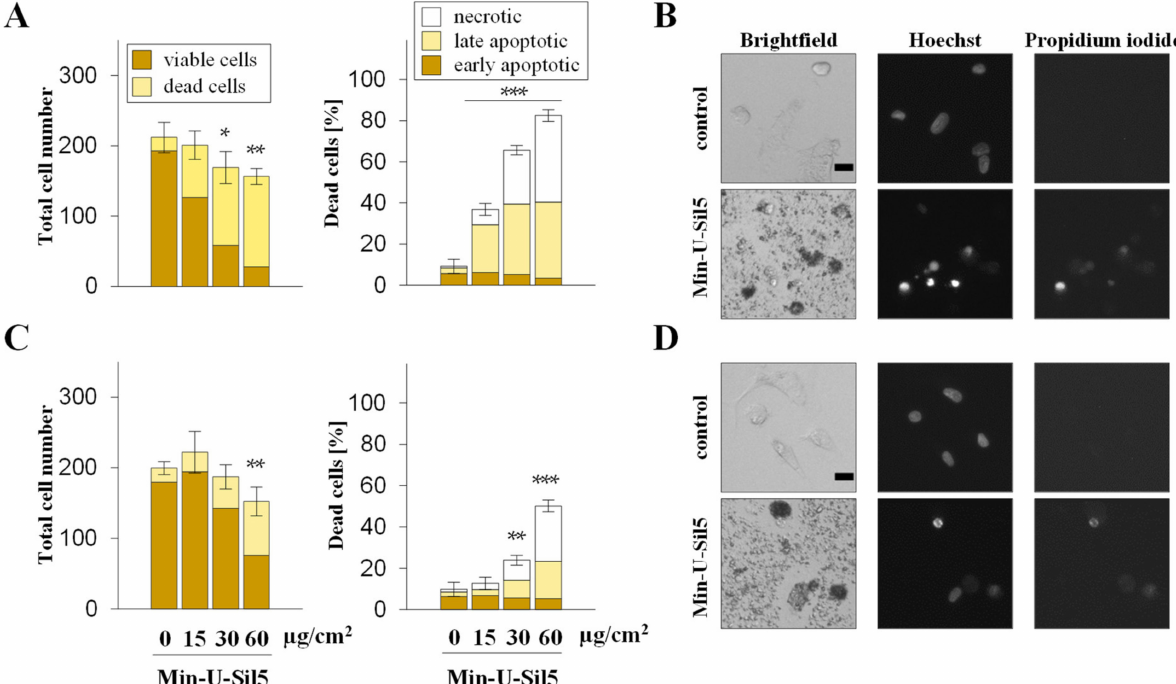
Figure 3. Proliferation and cell death of dTHP-1 cells after submerged exposure to Min-U-Sil5 in the absence ( A , B ) or presence of FBS ( C , D ). dTHP-1 cells were treated with 0, 15, 30, or 60 µ g/cm 2 Min-U-Sil5 (0, 50, 100, or 200 µ g/mL) for 24 h. The cells were stained with Hoechst and PI and analyzed by AHM. Shown is the total cell number divided into living and dead cells and the percentage of dead cells ( A , C ) relative to the total cell number divided into apoptotic (condensed chromatin), late apoptotic (condensed chromatin + PI-positive), and necrotic cells (PI-positive). The means ± SD of one representative experiment out of two each performed in quadruplicates are displayed. Representative images of cells exposed to 200 µ g/mL Min-U-Sil5 are shown ( B , D ). Statistical analysis was performed to assess differences between treated and untreated cells using student’s t -test: * ( p ≤ 0.05), ** ( p ≤ 0.01), *** ( p ≤ 0.001). Scale bar: 20 µ